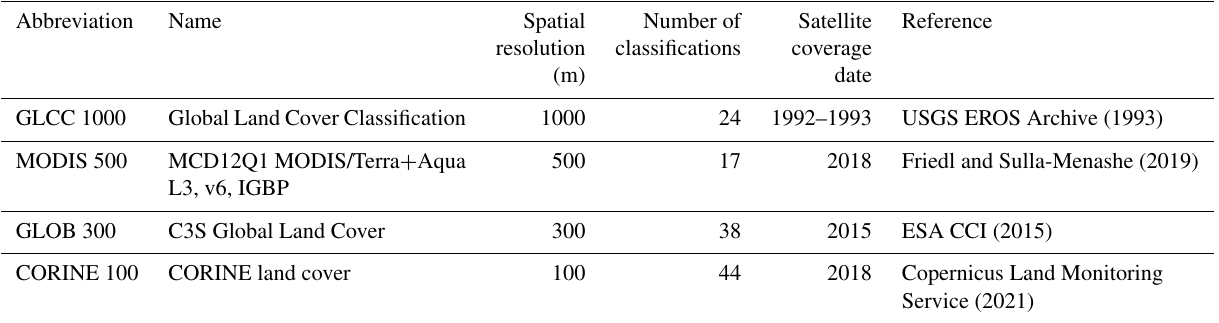
Table 2. Summary of the different coarse-resolution land cover products (spatial discretization between 100 and 1000m) used for creating the roughness